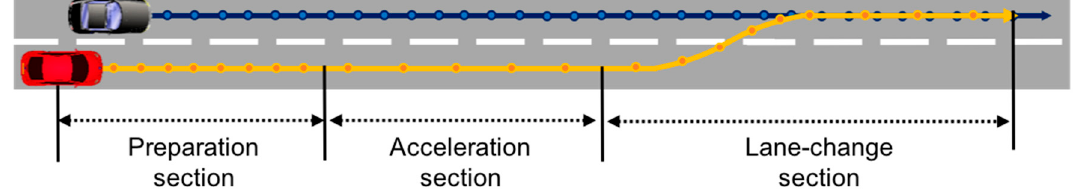
Figure 3. Construction of the expected lane change trajectory.